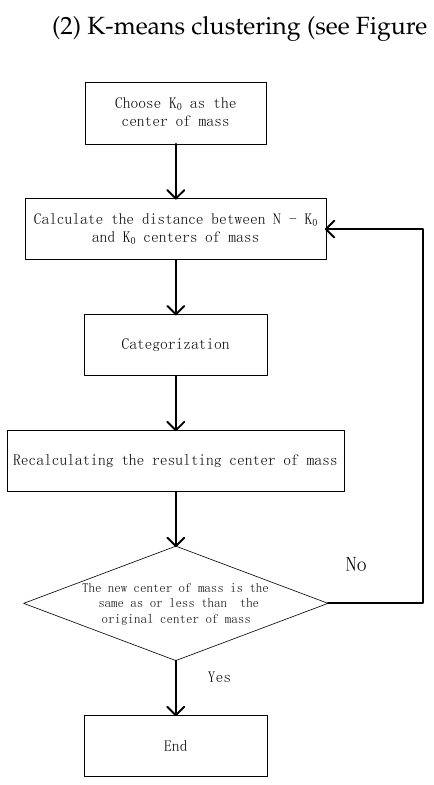
Figure 7. K-means algorithm specific steps.